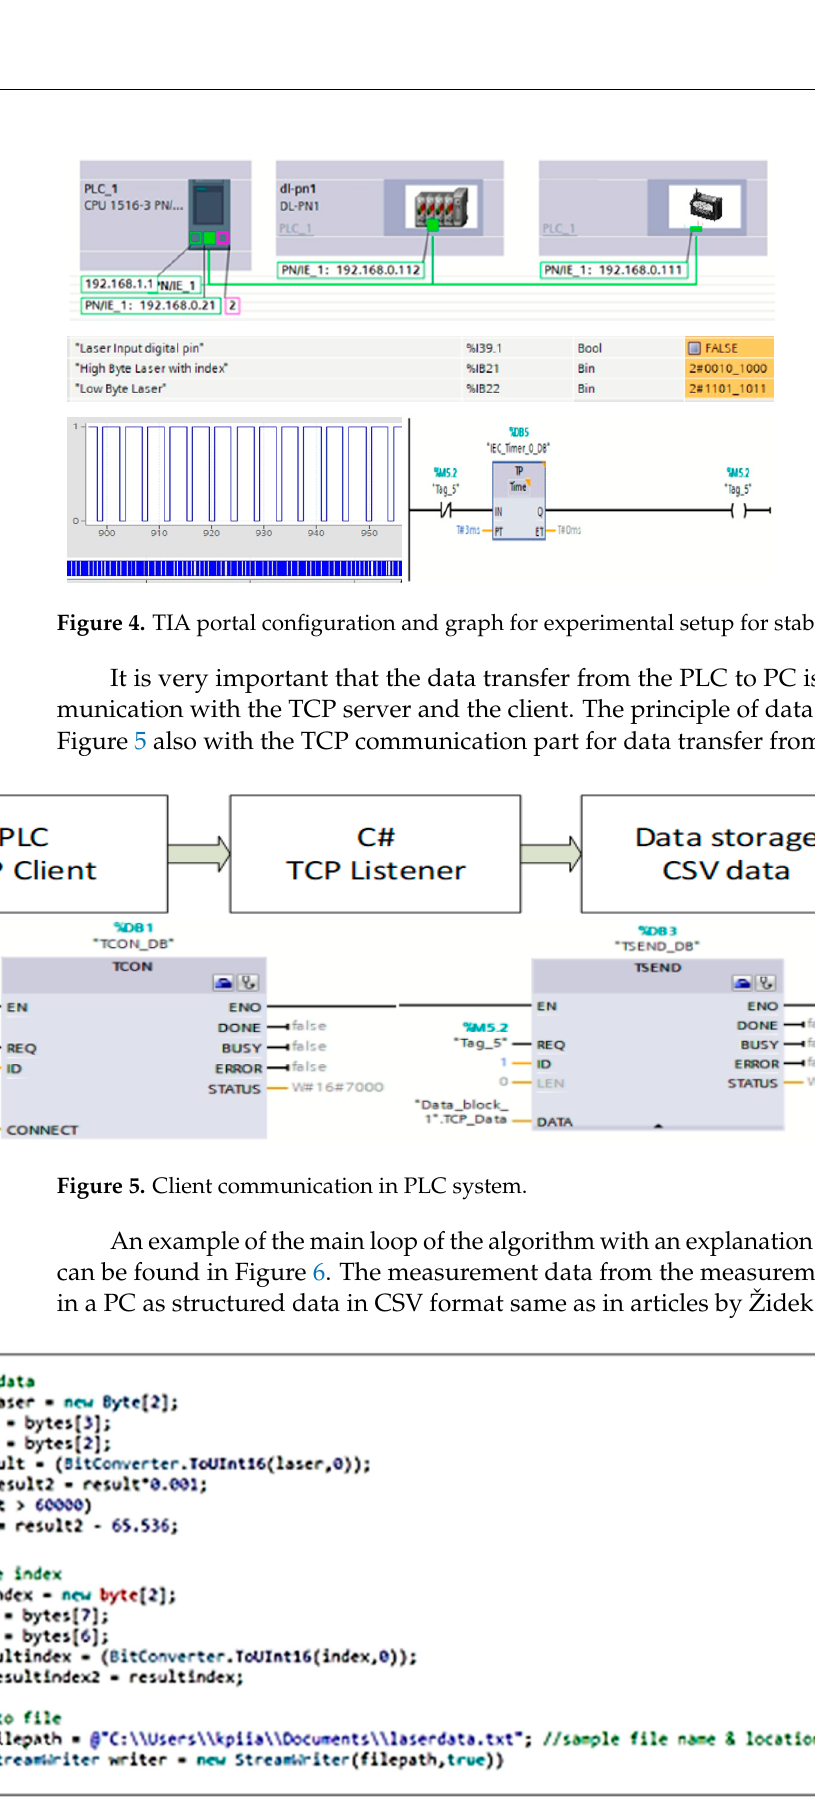
Figure 6. Main loop example for data transfer to value in mm.